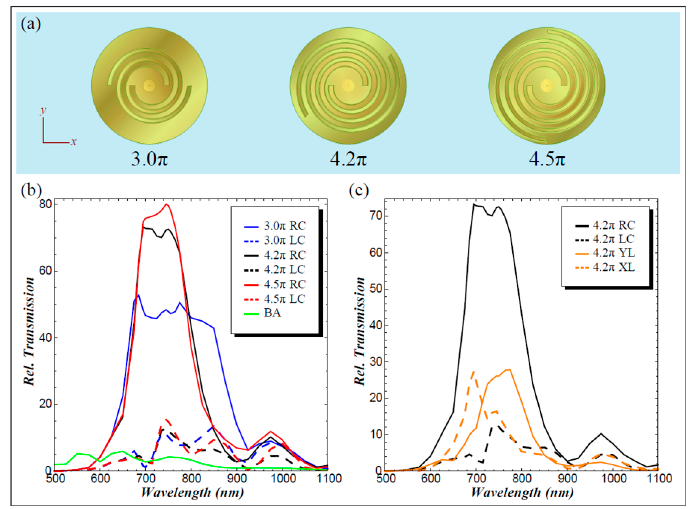
Figure 13. Simulated far-field transmission results. ( a ) Top view of the modeled geometries with different spiral arm lengths; ( b , c ) the relative transmissions normalized to the power incident on the circular aperture: ( b ) investigation of the spiral arm lengths; ( c ) comparisons among the RCP, LCP and linear ( x and y -directions) incidences. Reproduced with permission from [50]. Copyright Optical Society of America, 2011.